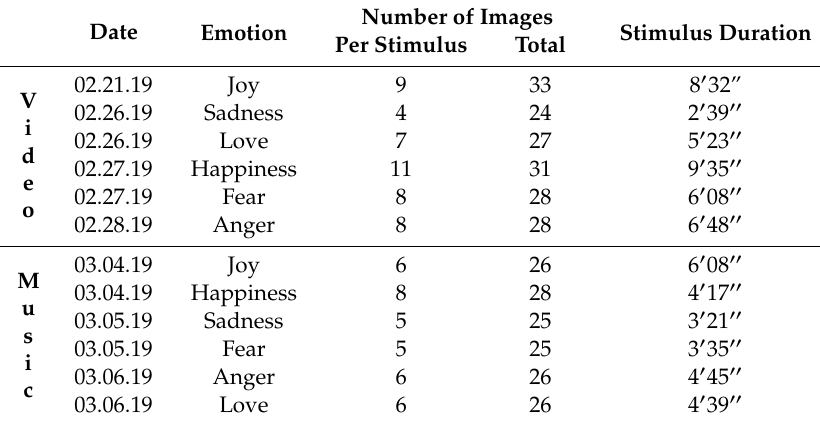
Table 3. Date, duration, and photos taken in each stimulus.